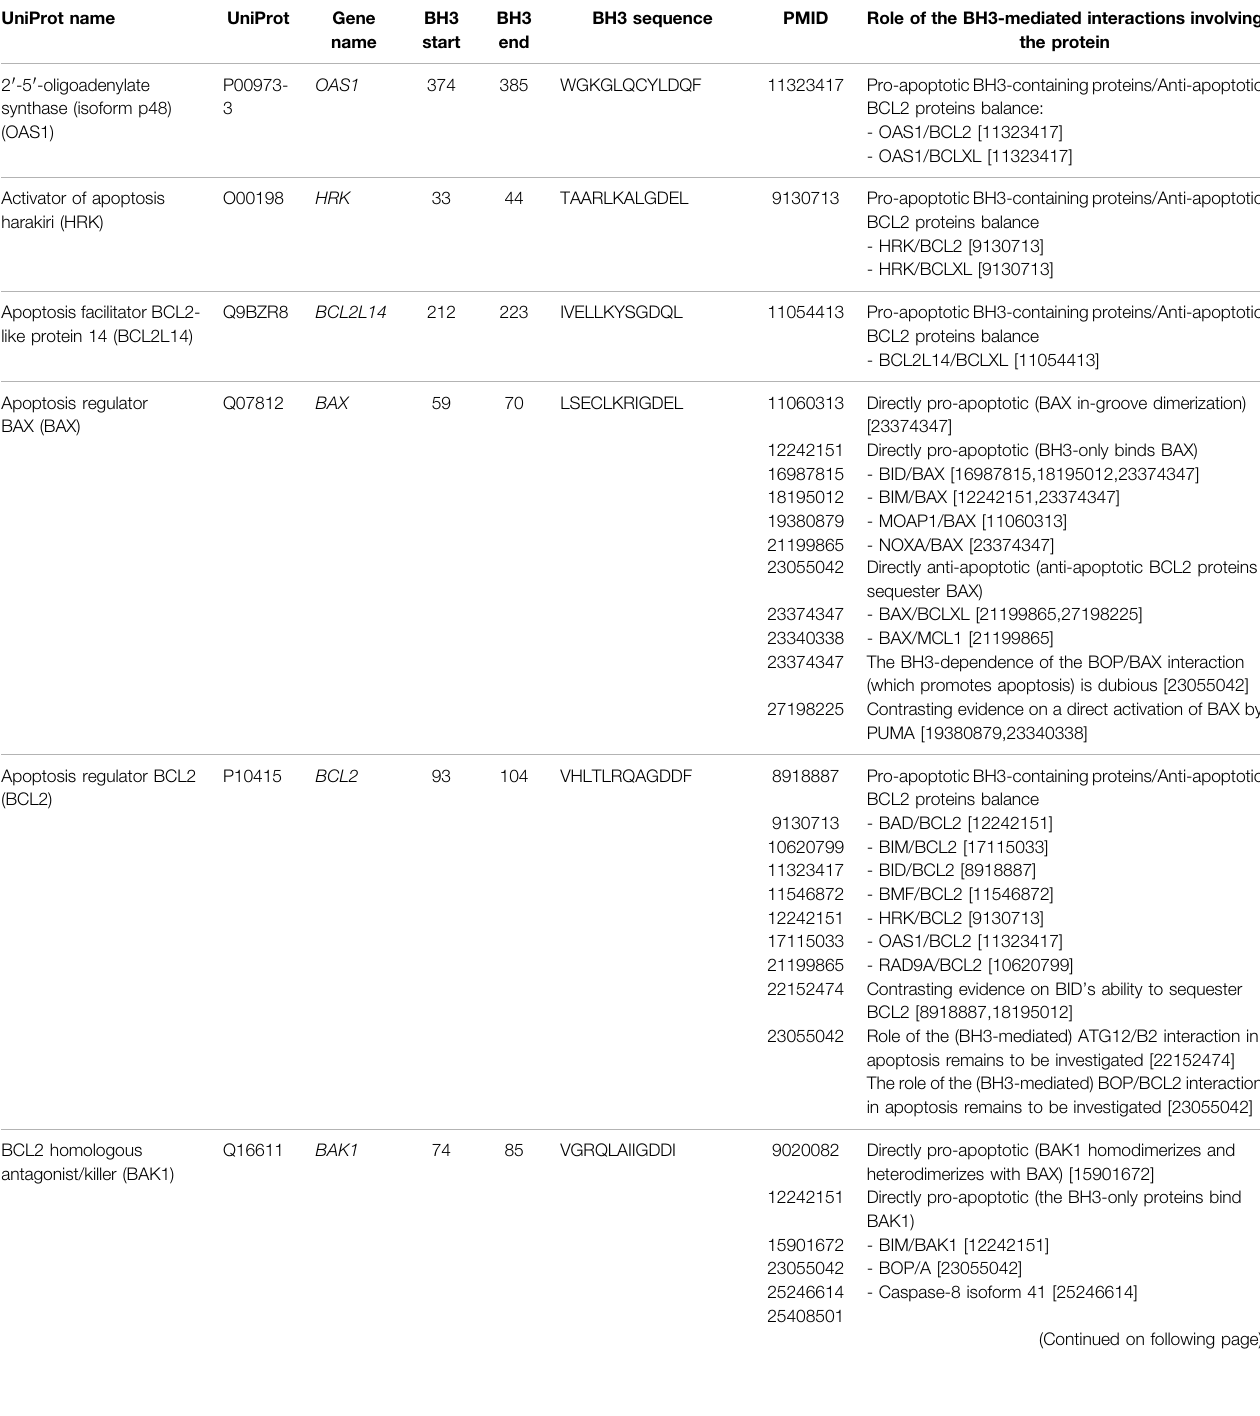
TABLE 1 | Experimentally validated BH3 motifs from human proteins. We included all members of the BCL2 family (both anti-apoptotic and pro-apoptotic) and BH 3 - containing interactors whose BH3s were reported as not dispensable for binding BCL2 proteins through deletion of the motif or mutations in the critical hotspots. The “ PMIDs ” columncontainsthePubMedIDsofthepublicationswhereBH3-mediated interactionsinvolving theproteins ofinterestweredescribed orwhere thefunctionalrole of such interactions was investigated (or both). The protein identi fi ers used throughout the text and in the fi gures are reported in parentheses in the fi rst column, after the UniProt name and the isoform speci fi cation (if available). For each interaction mentioned in the column “ Role of the BH3-mediated interactions involving the protein ” , the two binding partners are separated by a slash, and the one whose BH3 motif mediates the interaction is written fi